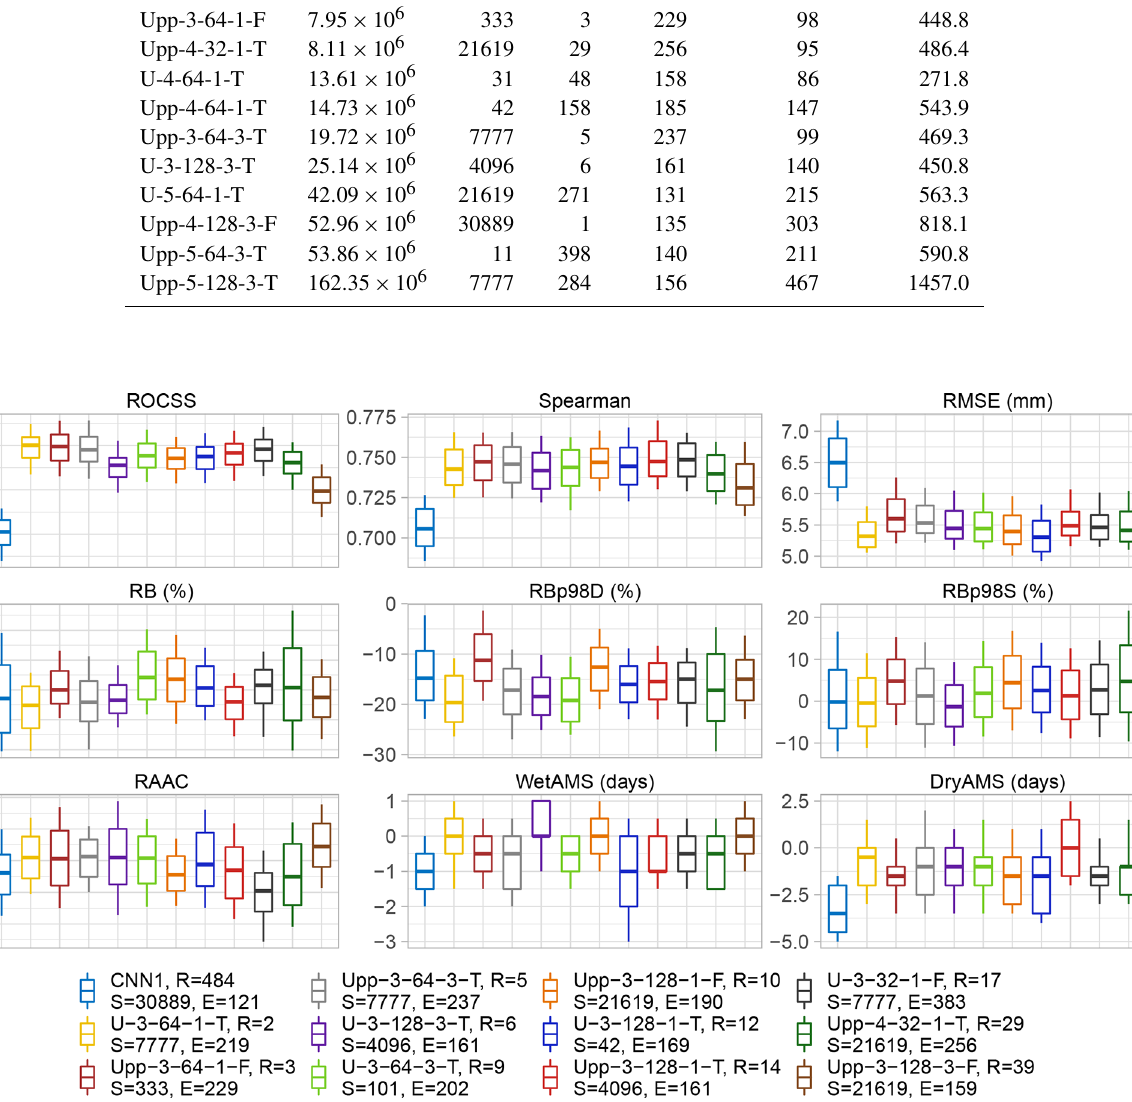
Figure 3. Validation metrics of CNN1 (benchmark) and the 11 best-performing architectures after pruning, ordered according to their rank- ings. Each sub-panel contains 12 boxplots, one per model, which summarizes the results for the 1916 pixels within the Eastern Ore Mountains. The boxes comprise the 25th and 75th percentile and the median, the whiskers the 10th and 90th percentile. The letters D and S after RBp98 stand for deterministic and stochastic approaches, respectively. Note that in the legend, ordered column-wise, alongside the nomenclature of the models details are added such as the overall ranking (R), the random seed number (S) of the run, and the number of epochs (E) needed to train the transfer functions (due to the patience of 75, the shown performance was achieved in E-75